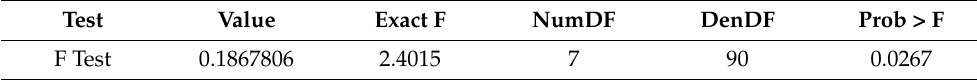
Table 3. All within interactions.